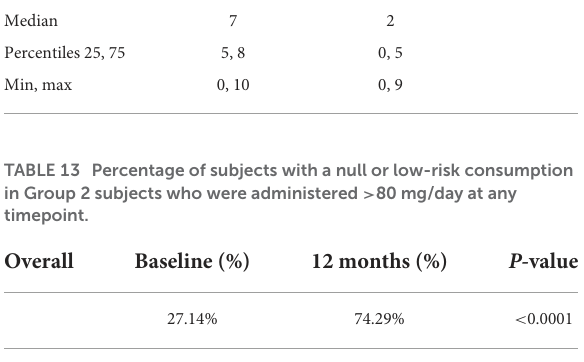
TABLE 11 Alcohol consumption in Group 2 subjects who were administered more > 80 mg/day at any timepoint.